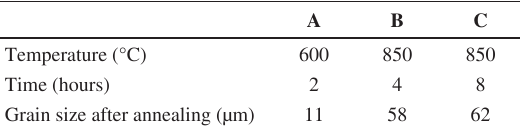
Table 3. Annealing parameters and final grain size of the non oriented electrical steel samples.